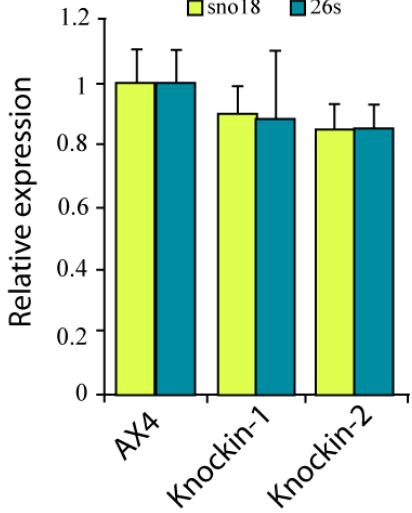
Figure 5. Pseudouridylation activity of D. discoideum dyskerin mutants. RNA was purified from wild-type (AX4) or dyskerin mutant (knockin-1, knockin-2) strains and treated, or not, with N -cyclohexil- N (cid:48) -(2-morpholinoethyl) carbodiimide metho- p -toluenesulphonate (CMCT). The amount of unmodified sno18 (yellow bars) or 26S rRNA (blue bars) was determined by RT-qPCR. The relative amount of RNA determined for treated versus untreated samples was referred to that obtained for AX4 RNA. Mean values and standard deviation obtained in triplicate experiments are